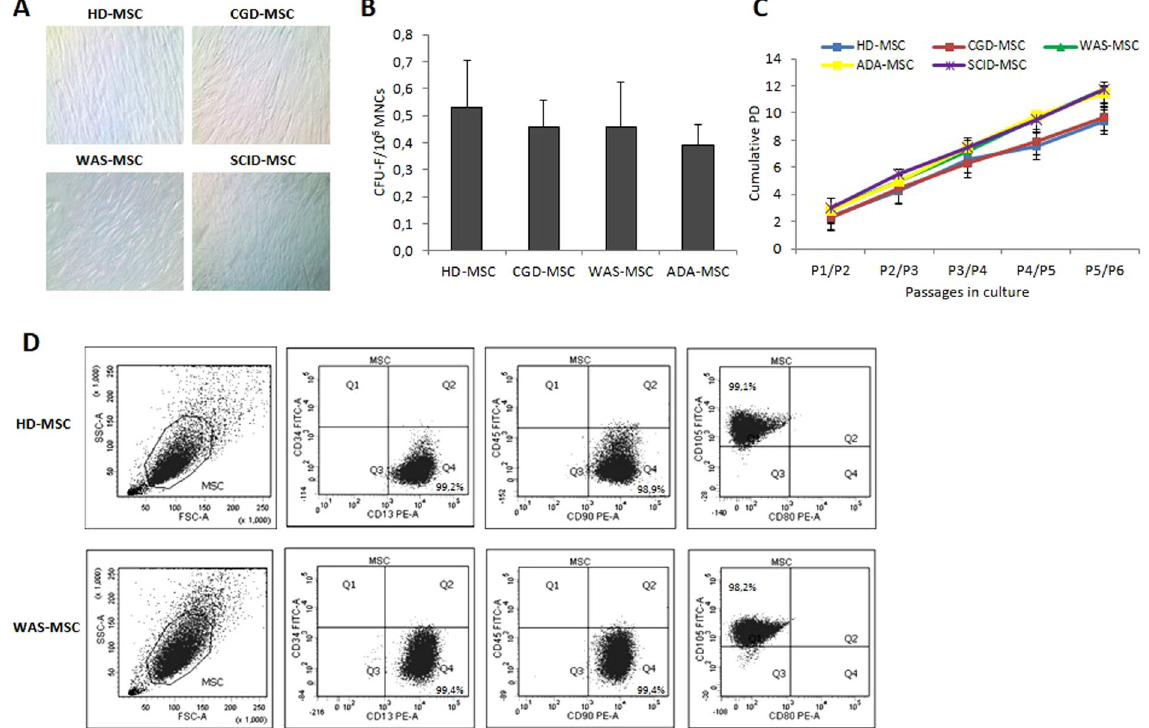
Figure 1. ( A ) Morphology of culture-expanded mesenchymal stromal cells (MSCs) obtained from PID patients (PID-MSCs) and from a pediatric healthy donor (HD-MSCs); a representative example for each disease is shown. MSCs from both patients and donors display the characteristic spindle-shaped morphology (magnification x4). ( B ) Fibroblast-colony forming unit- (CFU-F) ability of PID-MSCs as compared with HD- MSCs. Each bar represents the mean ± SEM of 7 CGD-MSCs, 15 WAS-MSCs, 6 ADA-MSCs and 15 HD-MSCs. CFUs for non-ADA SCID-MSCs were not reported because available only for 2 patients. ( C ) Cumulative population doublings (PDs) from passage (P) 1 to P5 of MSCs isolated from HDs (blue line), CGD- (red line), WAS- (green line), ADA- (yellow line) and SCID-patients (purple line). The data represent the mean ( ± SEM) of 7 CGD-MSCs, 15 WAS-MSCs, 6 ADA-SCID, 5 non-ADA SCID-MSCs and 15 HD-MSCs. ( D ) Immuno- phenotype of culture-expanded HD-MSCs and PID-MSCs from two representative samples (HD-MSCs in the upper panel and WAS-MSCs in the lower panel). Histograms of surface marker expression are similar: positive for CD13, CD90, CD105 surface antigens and negative for CD34, CD45 and CD80 molecules. Abbreviations: MNCs, mononuclear